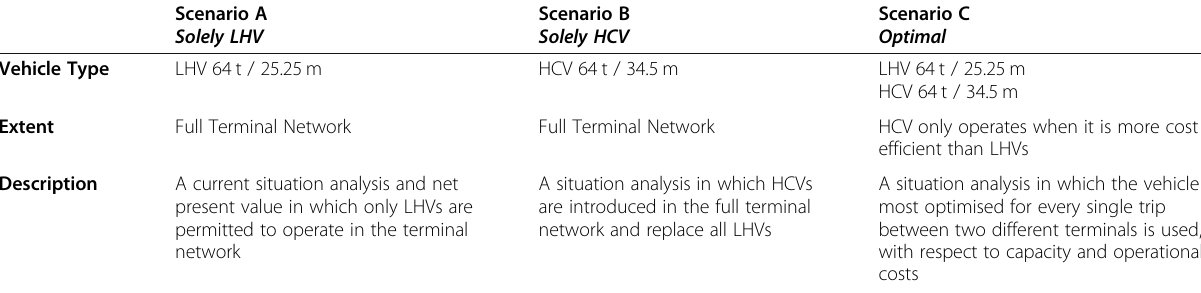
Table 1 Map of the different Scenarios